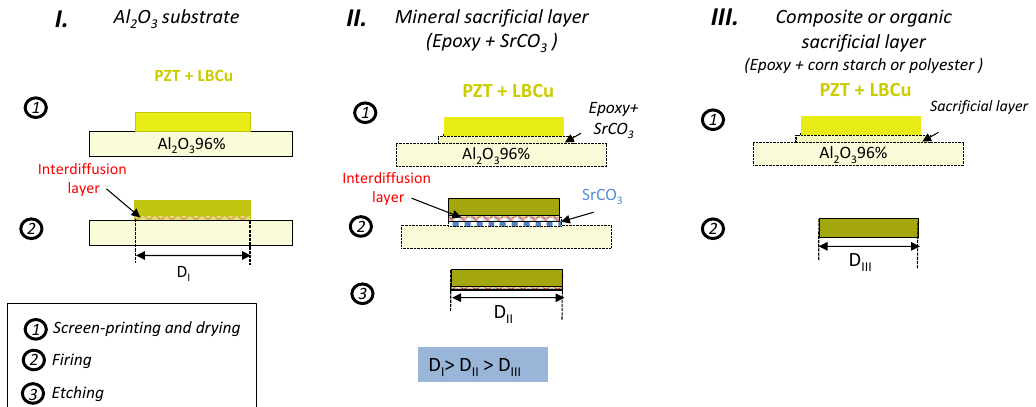
Figure 7. Simplified scheme showing phenomena occurring during the PZT + LBCu sintering of screen-printed thick films (disk shape) on a mineral or organic type sacrificial layer. D is the final diameter of the disk cross-section. Table 2. Comparison of the properties of PZT films used in thick-film ceramic MEMS [9,24–25,30– 31,42,46,49–51].